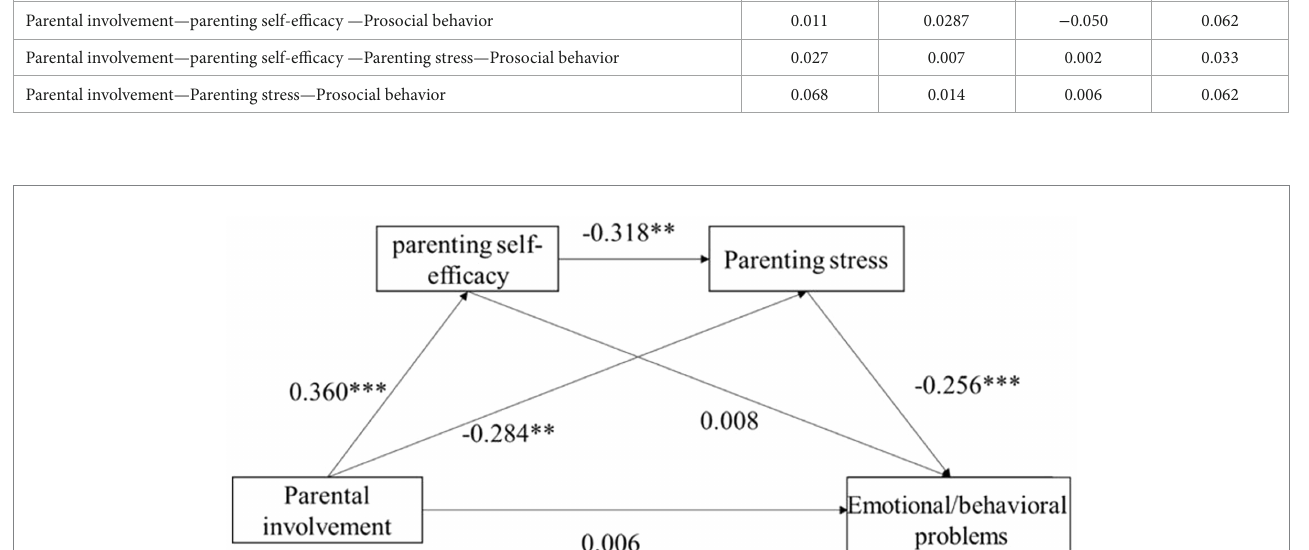
FIGURE 2 Mediation model testing the association between parental involvement and children’s emotional/behavioral problems via parenting self-efficacy and parenting stress. * p < 0.05; ** p < 0.01; *** p <